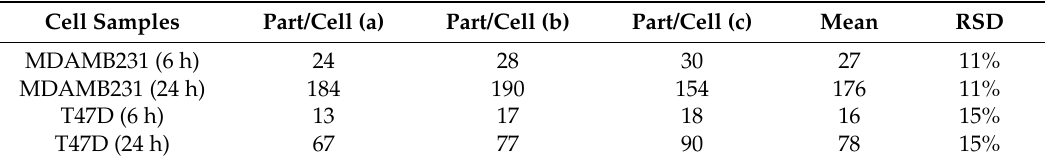
Table 4. Comparison of the average number of nanoparticles per cell between the three methods of quantification: particle number counting with sp-ICPMS (a), particle mass with sp-ICPMS (b), and particle mass with ICPMS (c). RSD: Relative Standard Deviation. Cell Samples Part/Cell